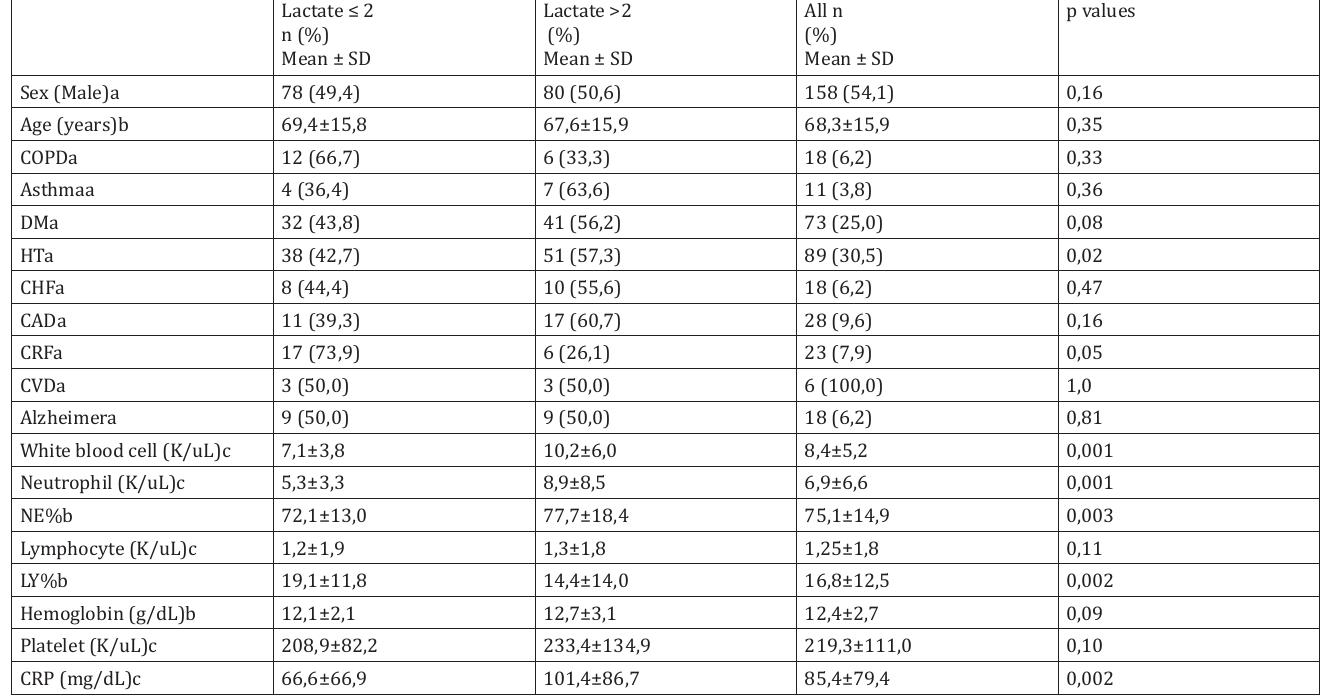
Characteristic of the study